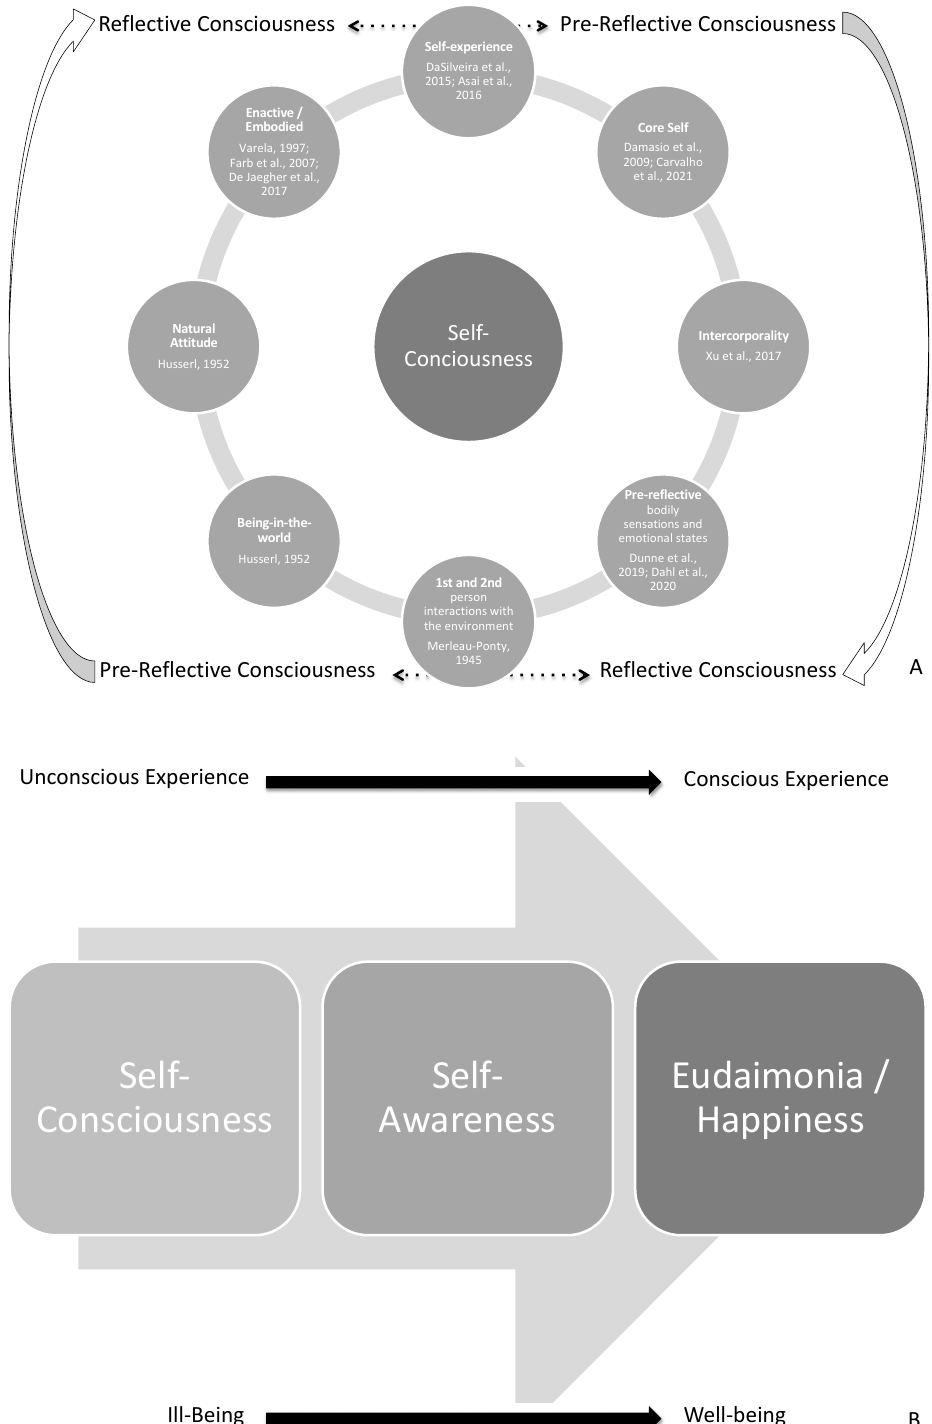
Figure 9. Sample characterization and neurophenomenology schematics ( A , B ). 2 graphical representations of the cognition of the neurotypical self are presented. In ( A ), the self-consciousness trait is shown as a prerequisite to self-awareness. The self-consciousness constructs examined in the paper are schemed: self-experience [34,35], core self [117,120], intercorporality [114], pre-reflective bodily sensations and emotional states [14,63], 1st and 2nd person interactions with the environment [140], being-in-the-world [139], natural attitude [139] and enactive/embodied [29,59,136]. In ( B ), it is given a conceptual analysis of